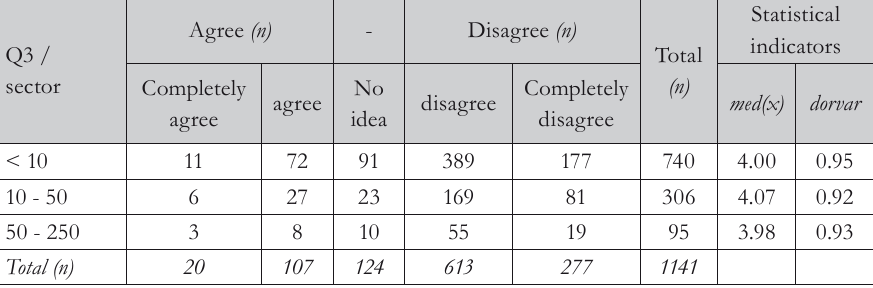
Tab. 11 – Pivot table for Q3b absolute frequency and Statistical characteristics. Source: authors